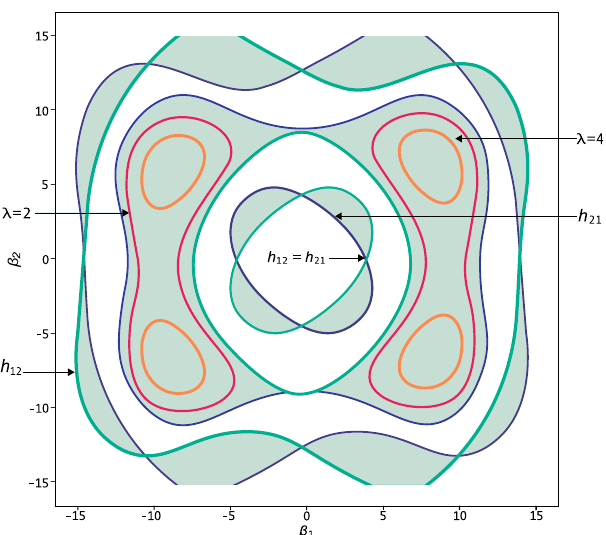
� < 2 , correspond to the clear | | 2 , can be tracked (cid:31) | | = (cid:31) 2 or = =